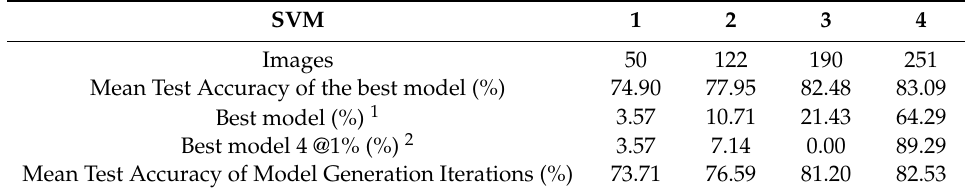
Table 1. Support vector machine (SVM) test accuracy results.